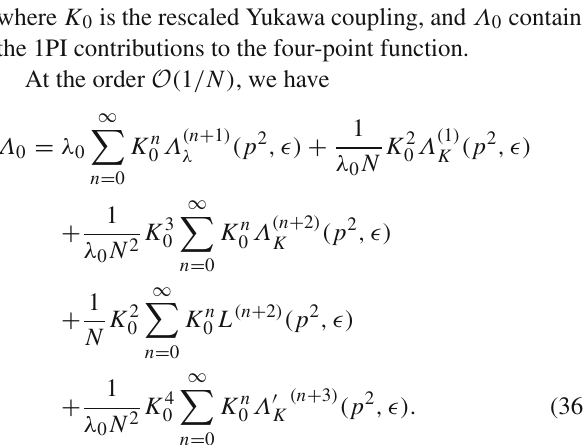
(cid:5) ∞ ˜ ω ( n ) / N n . The explicit formulae for the ± n = 1